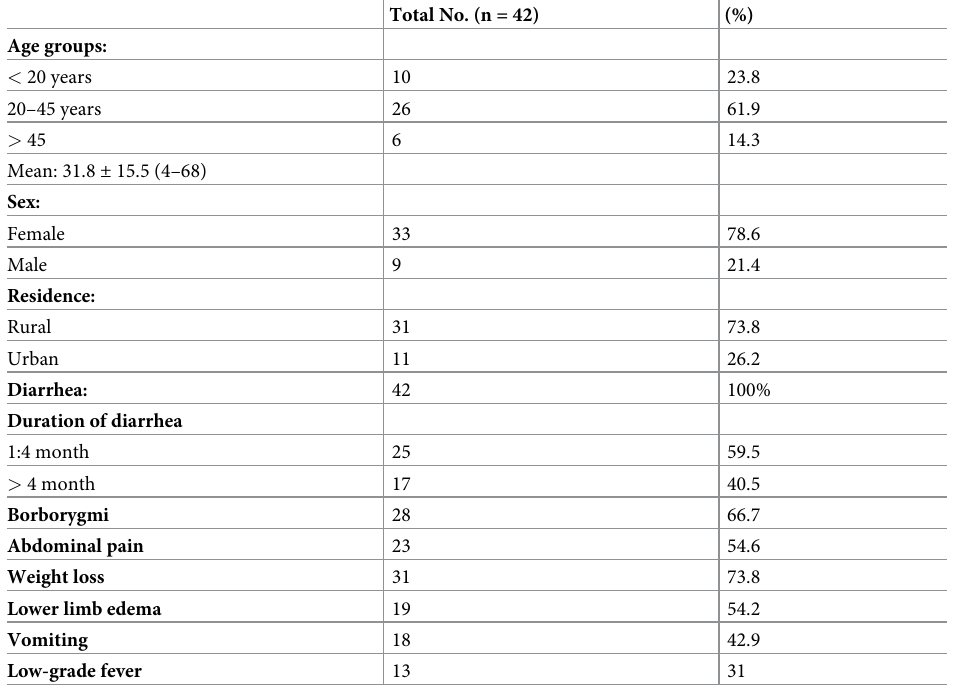
Table 1. Demographic characteristics and clinical data of the study